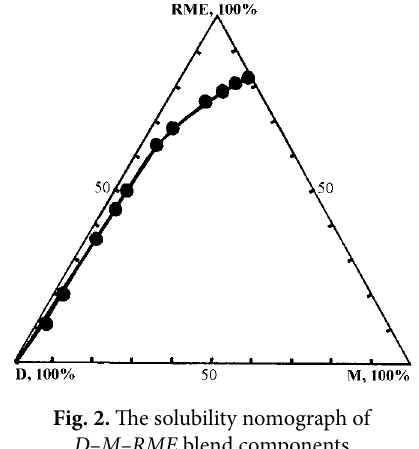
Fig. 2. The solubility nomograph